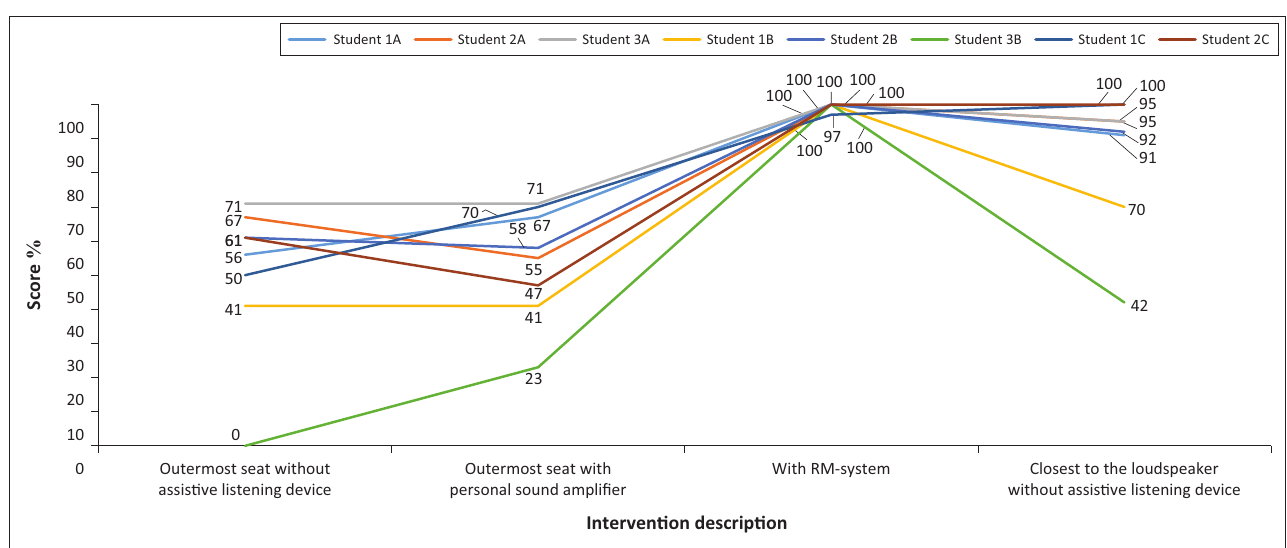
FIGURE 1: Digit triplets test scores for the eight students with hearing impairment at the three schools.